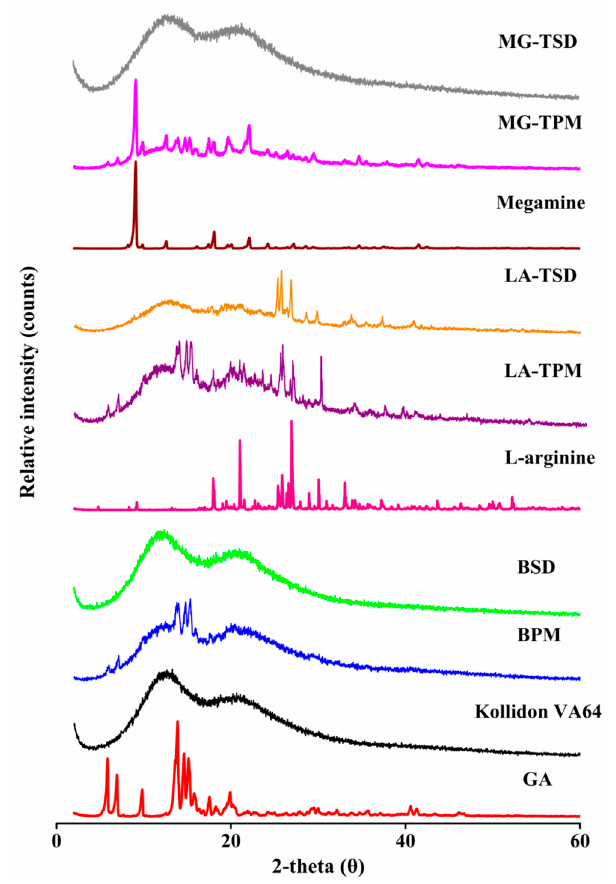
Figure 6. PXRD images of GA, Kollidon ® VA64, and their PMs / SDs with and without alkalizers.